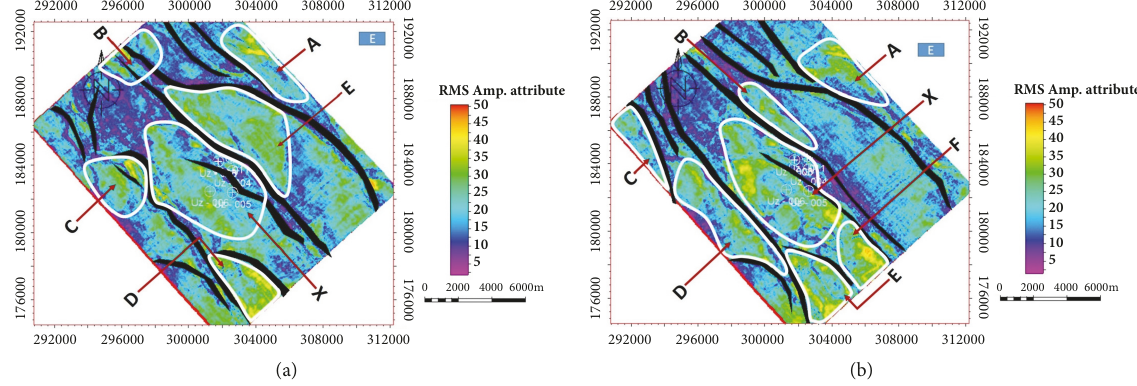
Figure 11: (a) Amplitude (root-mean-square amplitude attribute) extracted/generated map of D5000 reservoir showing identified hydrocarbon leads (A, B, C, D, and E) away from the producing zone “X.” (b) Amplitude (root-mean-square amplitude attribute) extracted/generated map of D9000 reservoir showing identified hydrocarbon leads (A, B, C, D, E, and F) away from the producing zone “X”. (Note that zone “X” is a prospect, which has been drilled